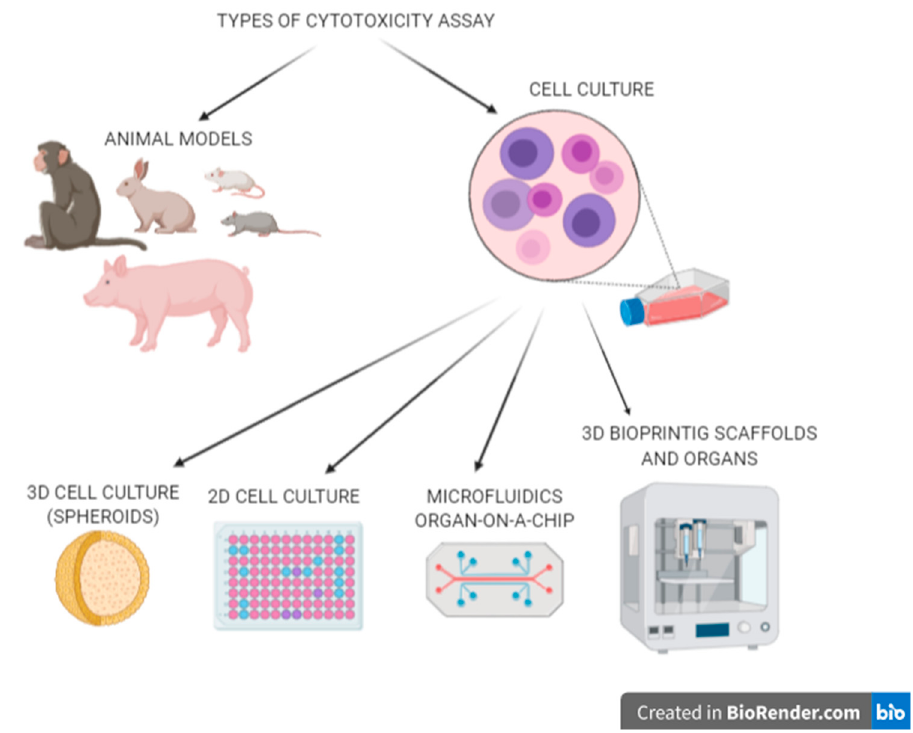
Figure 1. Types of biological materials and techniques used in cytotoxicity assays during potential new drug testing.